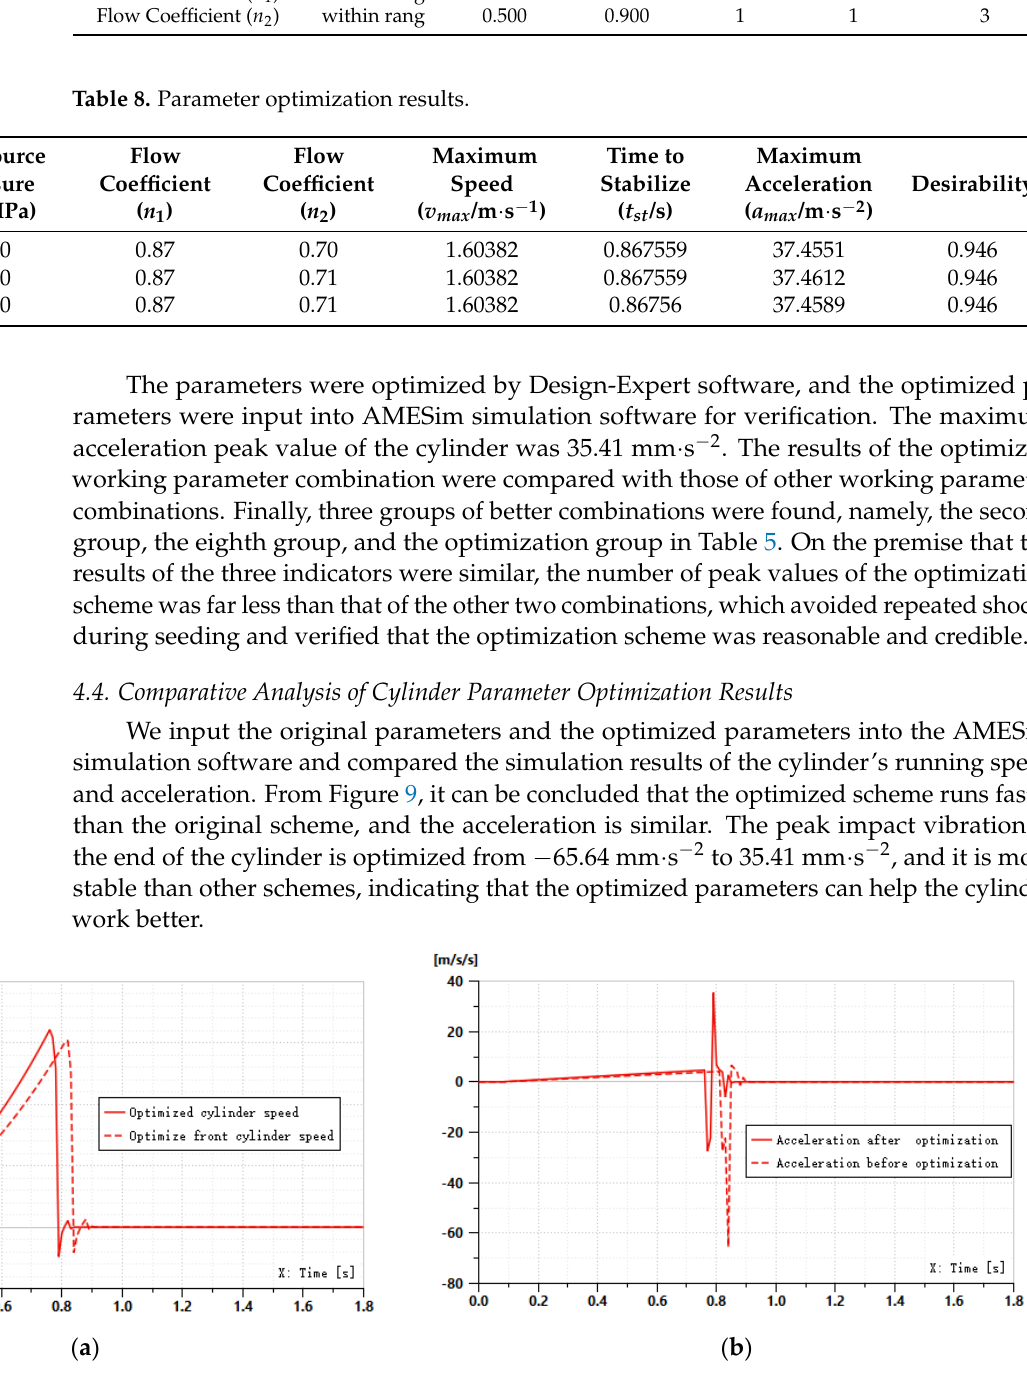
( d ) Figure 10. Test equipment and conditions: ( a ) 72-hole plug seedlings; ( b ) growth of cucumber seed- lings; ( c ) pick-up mechanism; ( d ) bench test of picking seedlings. 5.2. Test Design and Evaluation Index (1) Test Design: The air source pressure is set to 0.5 MPa via the pressure regulating valve, the flow coefficient of the speed control valve is set to 0.9 by the flow meter, and the flow coefficient of the safety valve is set to 0.9. In reference to JB/T 10291-2013 [33], we used three trays of 72-hole cucumber seedlings as a group of experimental objects, and the frequency of seed- ling picking was adjusted to 20 times·min − 1 and 24 times·min − 1 through the PLC control program. The institution carried out continuous seedling picking and continuous seed- ling0casting experiments. We then set the air pressure to 0.4 MPa and selected the pre- ferred parameters: The flow coefficient of the speed control valve was 0.87 and the flow coefficient of the safety valve was 0.7. The above steps were then repeated to carry out comparative experiments.